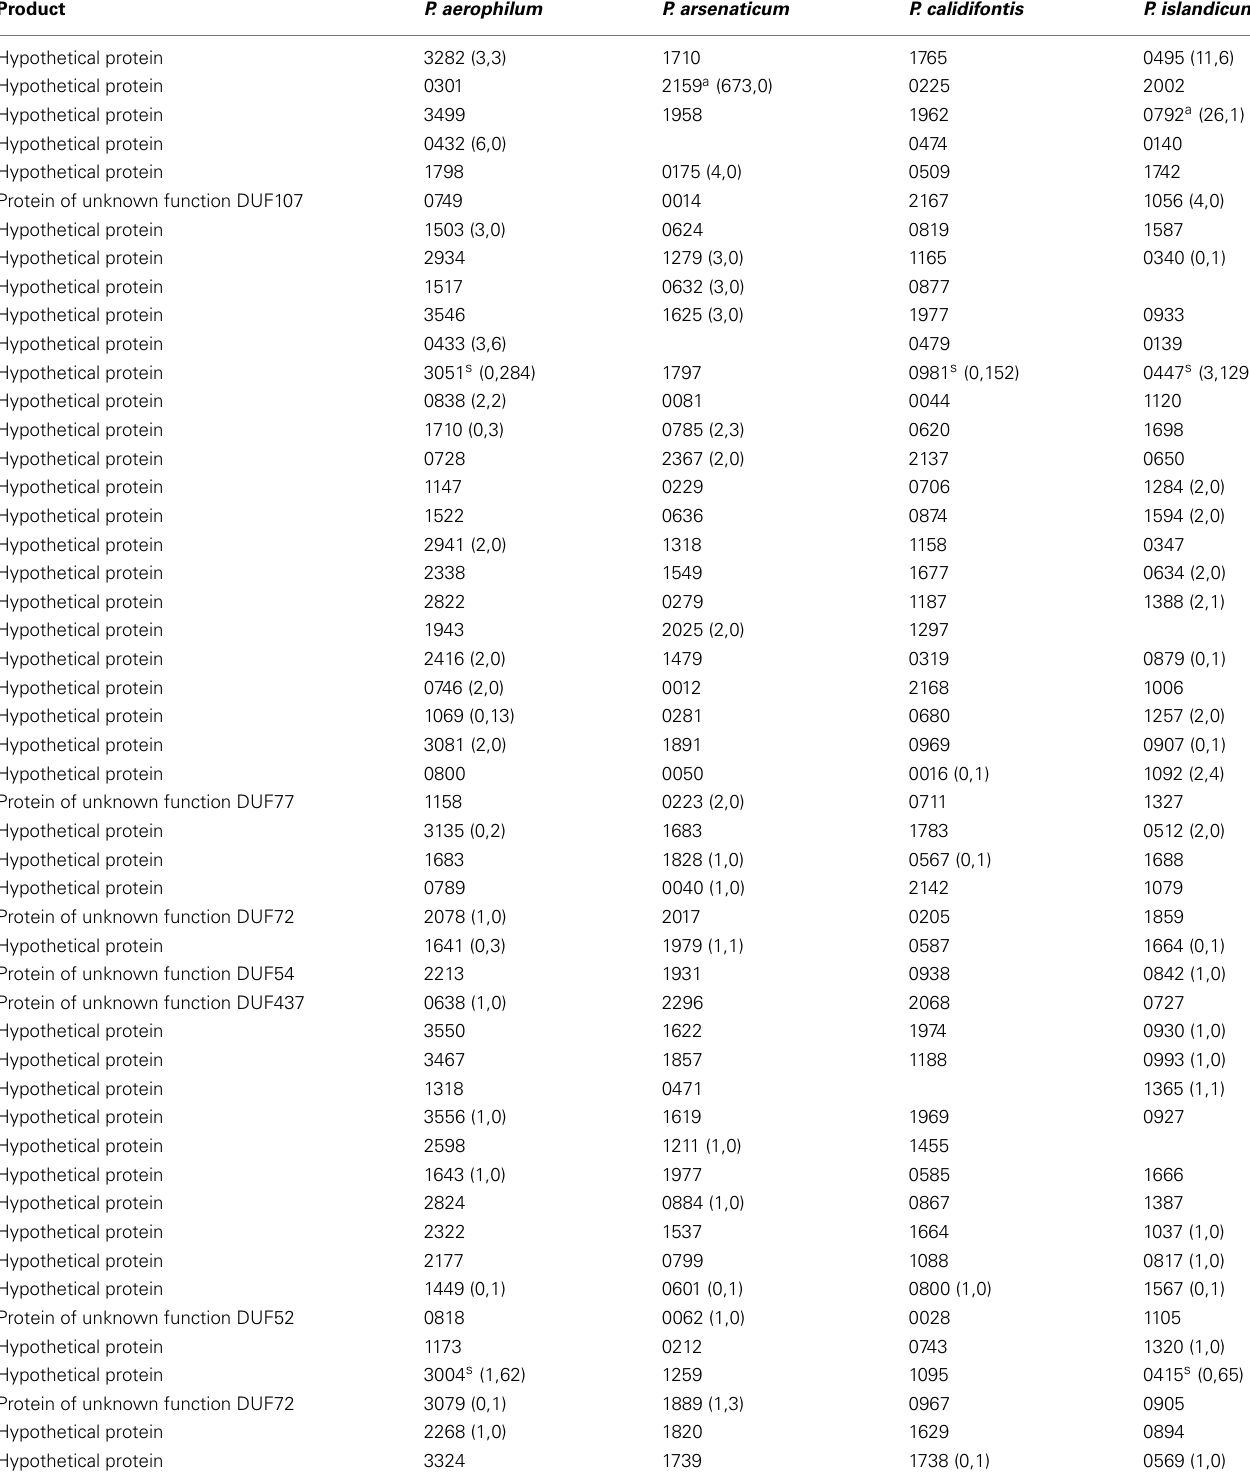
TableA3 | Hypothetical genes with 5’ sequencing reads. Orthologous groups, read counts, and footnotes displayed are as described in TableA1